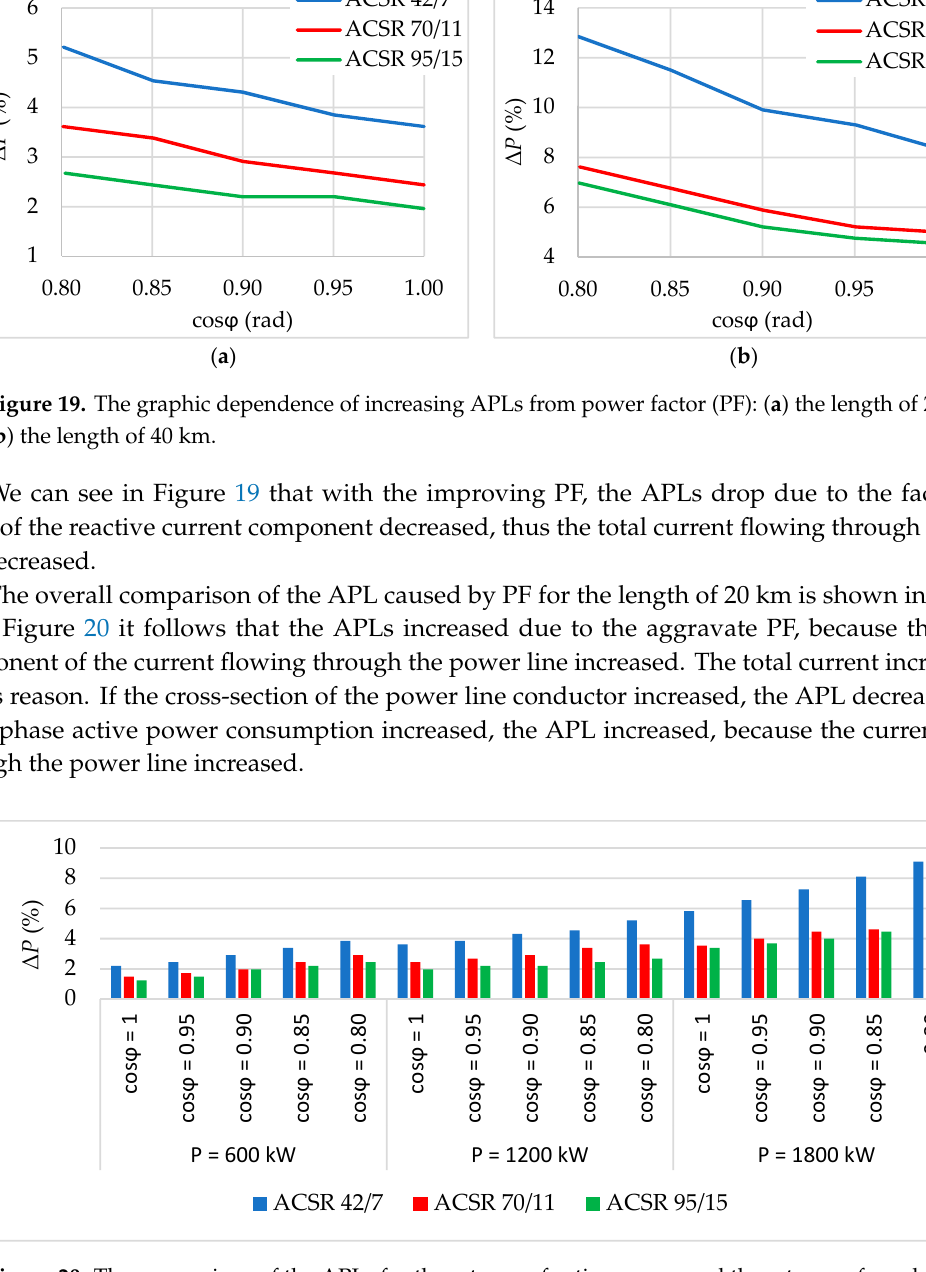
Figure 18. Distribution grid for the analysis of the influence of individual factors.